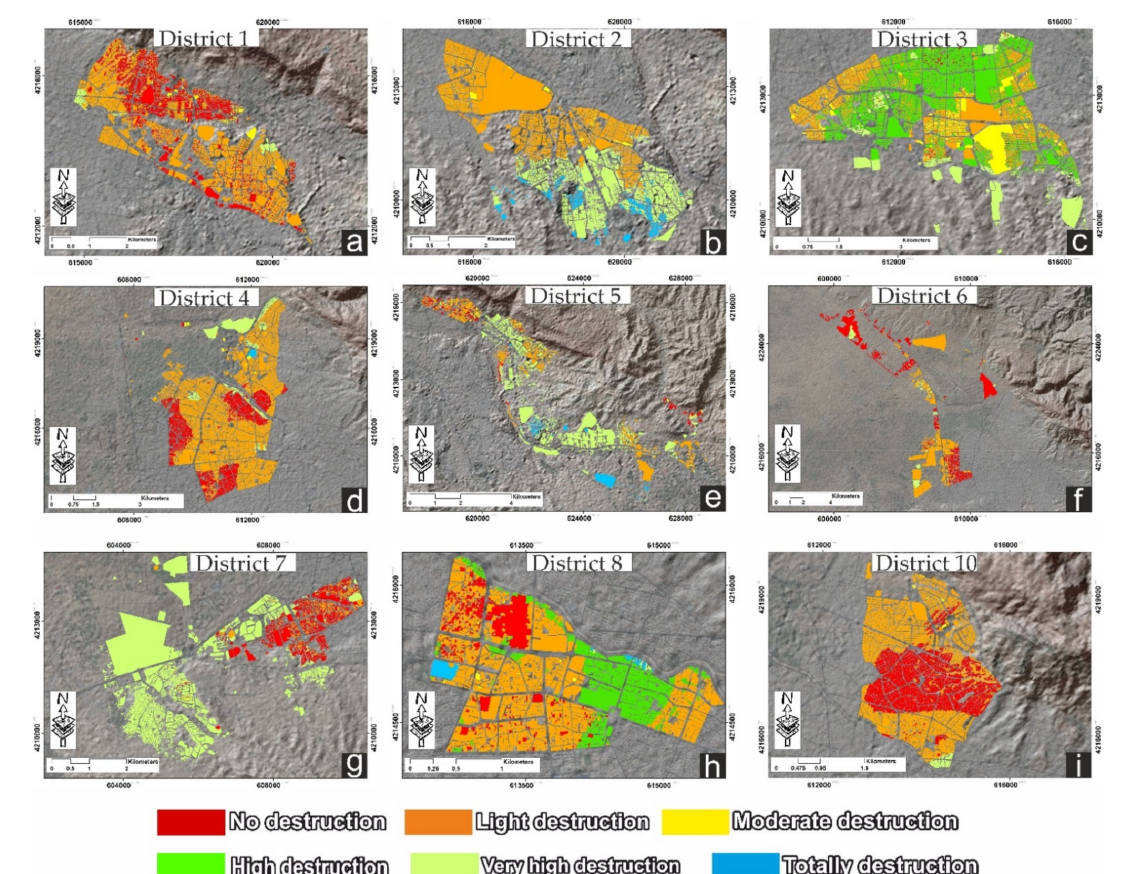
Figure 23. Extent of the destruction of structures for the earthquake of 1721 with a magnitude of 7.3 Richter, by municipal area. ( a ) district 1; ( b ) district 2; ( c ) district 3; ( d ) district 4; ( e ) district 5; ( f ) district 6; ( g ) district 7; ( h ) district 8; ( i ) district 10.